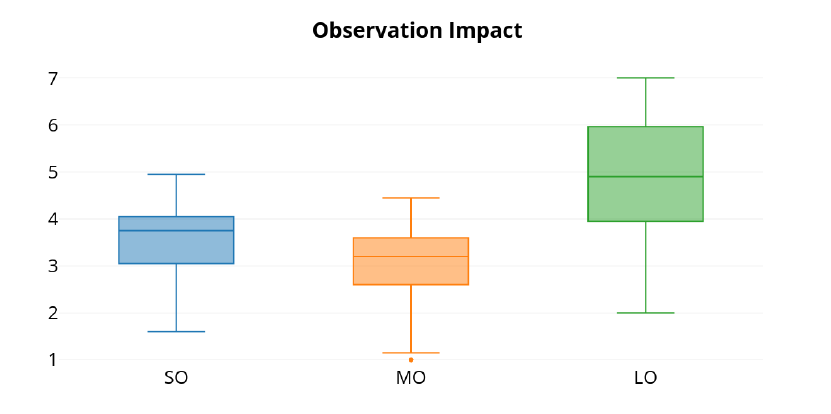
Figure 6. Participants’ responses for the self-agency and impact of the observation task from the conducted experiment. SO, self-observation; MO, observation through a virtual mirror; LO, observation during